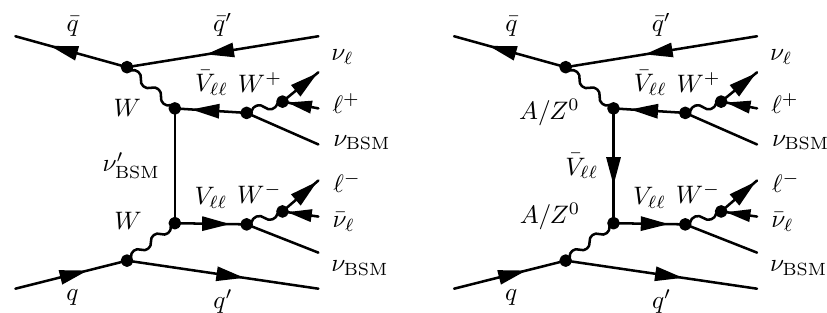
Figure 3. Leading-order Feynman diagrams for the VBF topologies. The same nomenclature as seen in figure 2 applies here. ν 0 correspond to any BSM neutrino. BSM